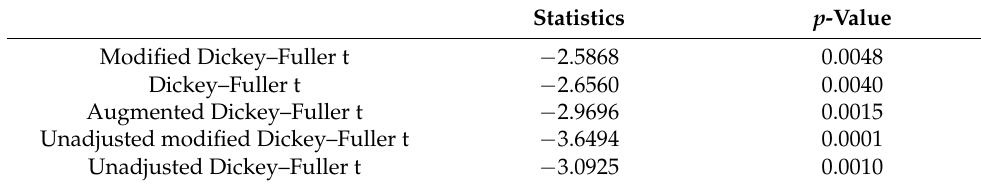
Table 4. Co-integration test results of variables.